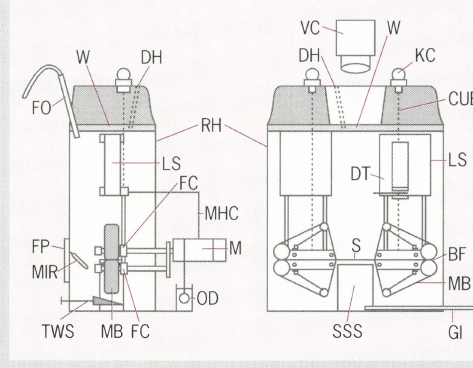
Fig. 3: Elongational recovery, expressed as recovered stretch A,. for blends of PS/PMMN stretched with a strain rate of= 0.1s-1 up to